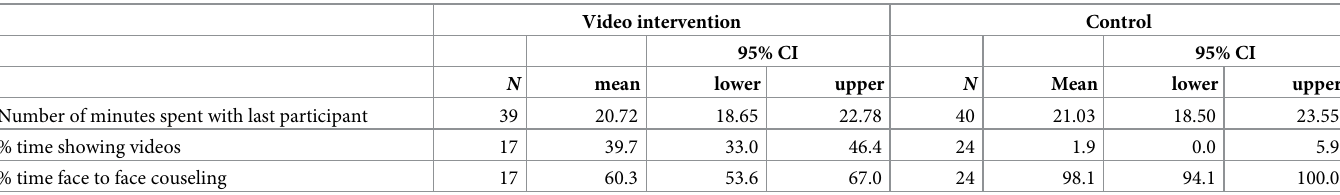
Table 5. Time usage during home visits.